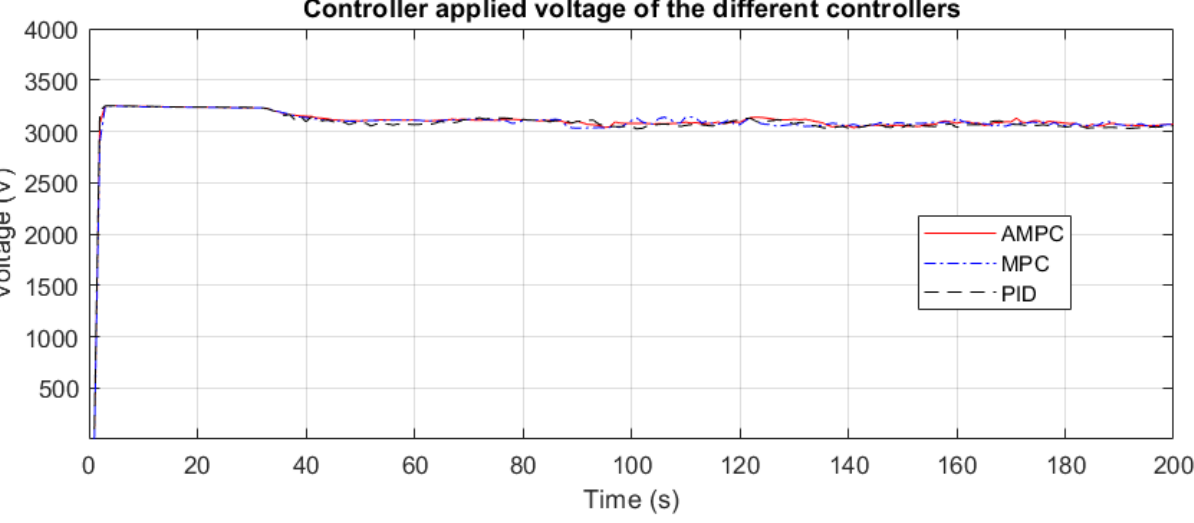
Figure 6. Temperature response heating orange juice using PID, MPC, and AMPC controller.